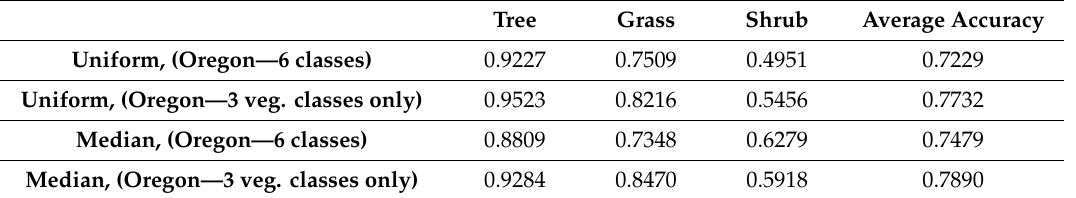
Table 21. Vegetation class accuracy for six and three-class models in DeepLabV3 +